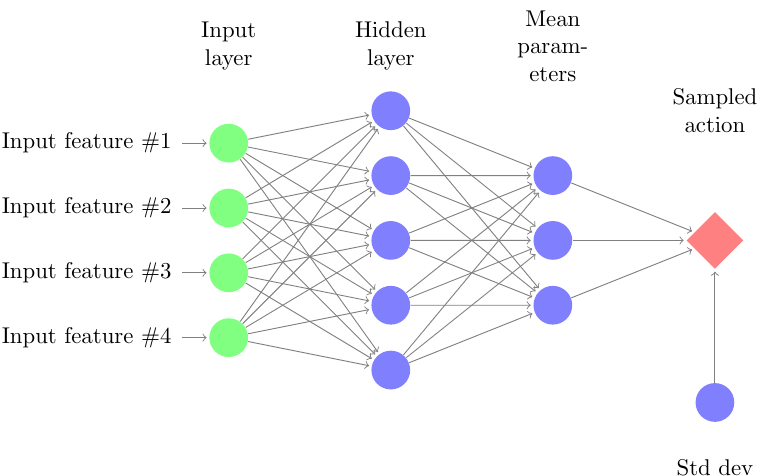
Figure 2. Neural network policy parameterization. The neural net maps the state, in this case a 4 dimensional space, to the mean, µ , of the Gaussian policy. The output is then a sample from the Gaussian policy N ( µ , σ 2 ) . The σ parameter is in this work the output from a neural